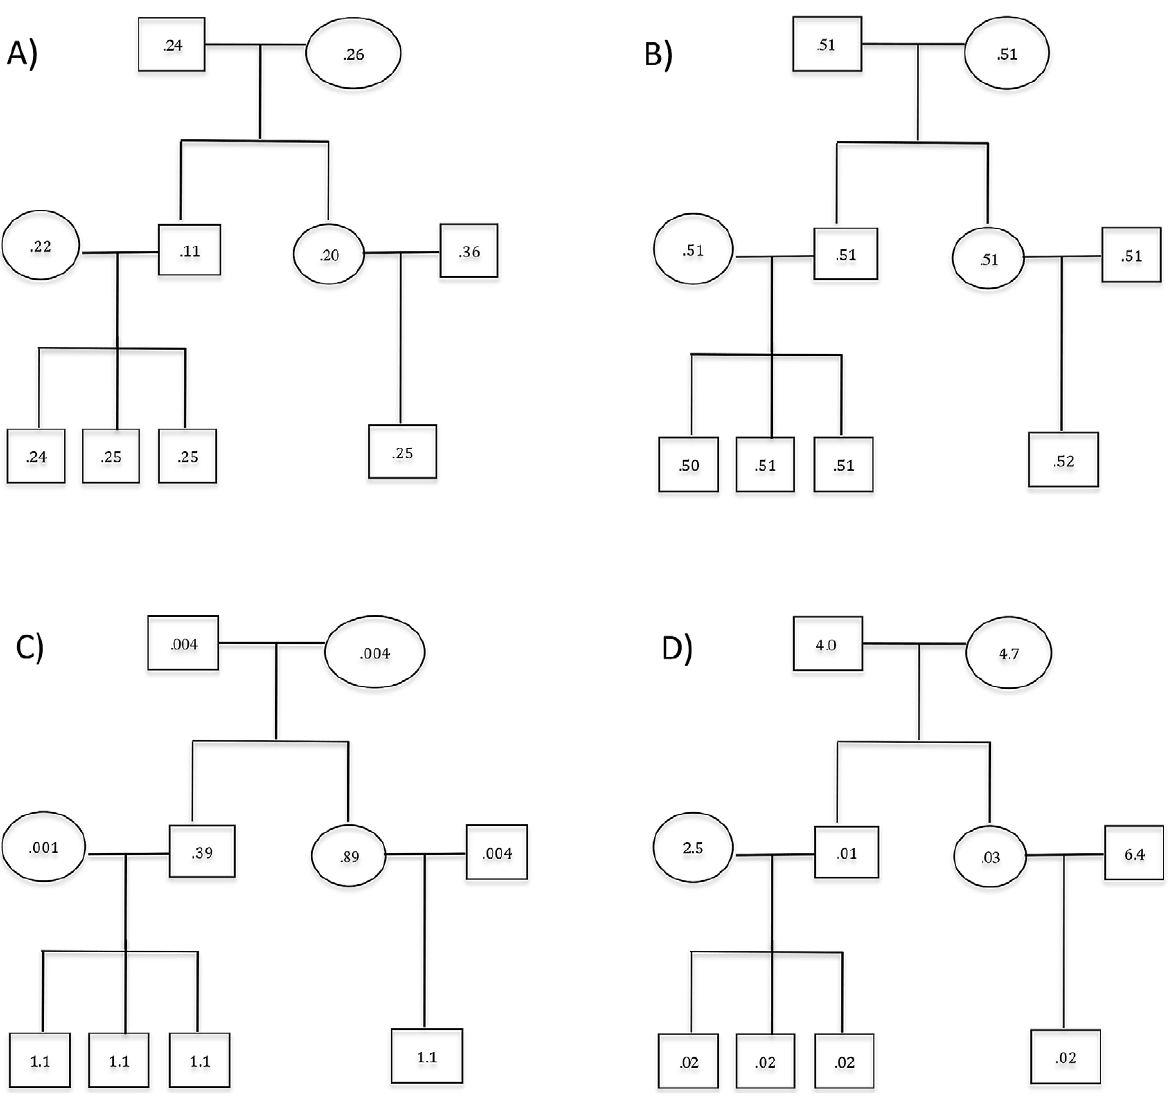
Figure 1. Three-generation extended pedigrees. A) is a 3-generation extended pedigree with numbers labeling the individual heterozygous genotype mismatch rates (%) at coverage of 15 6 with base quality of Q20 without mapping error and panel B) labels the corresponding mismatch rates for the standard approach of ignoring relatedness. Panel C) and D) display the heterozygous mismatch rates (%) when a fixed sequencing effort of 150 6 is allocated differently to family members: Panel C) is for the situation where the founders are allocated 30 6 while non-founders have 5 6 and in Panel D) founders and non-founders have coverage of 6 6 and 21 6 respectively.